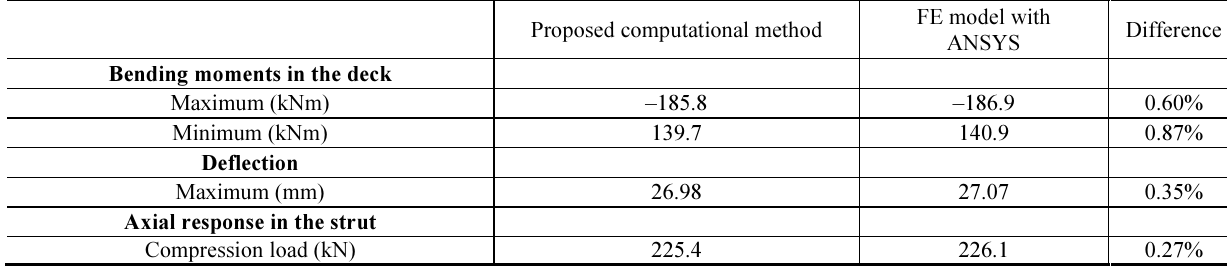
Table 1. The results of the numerical